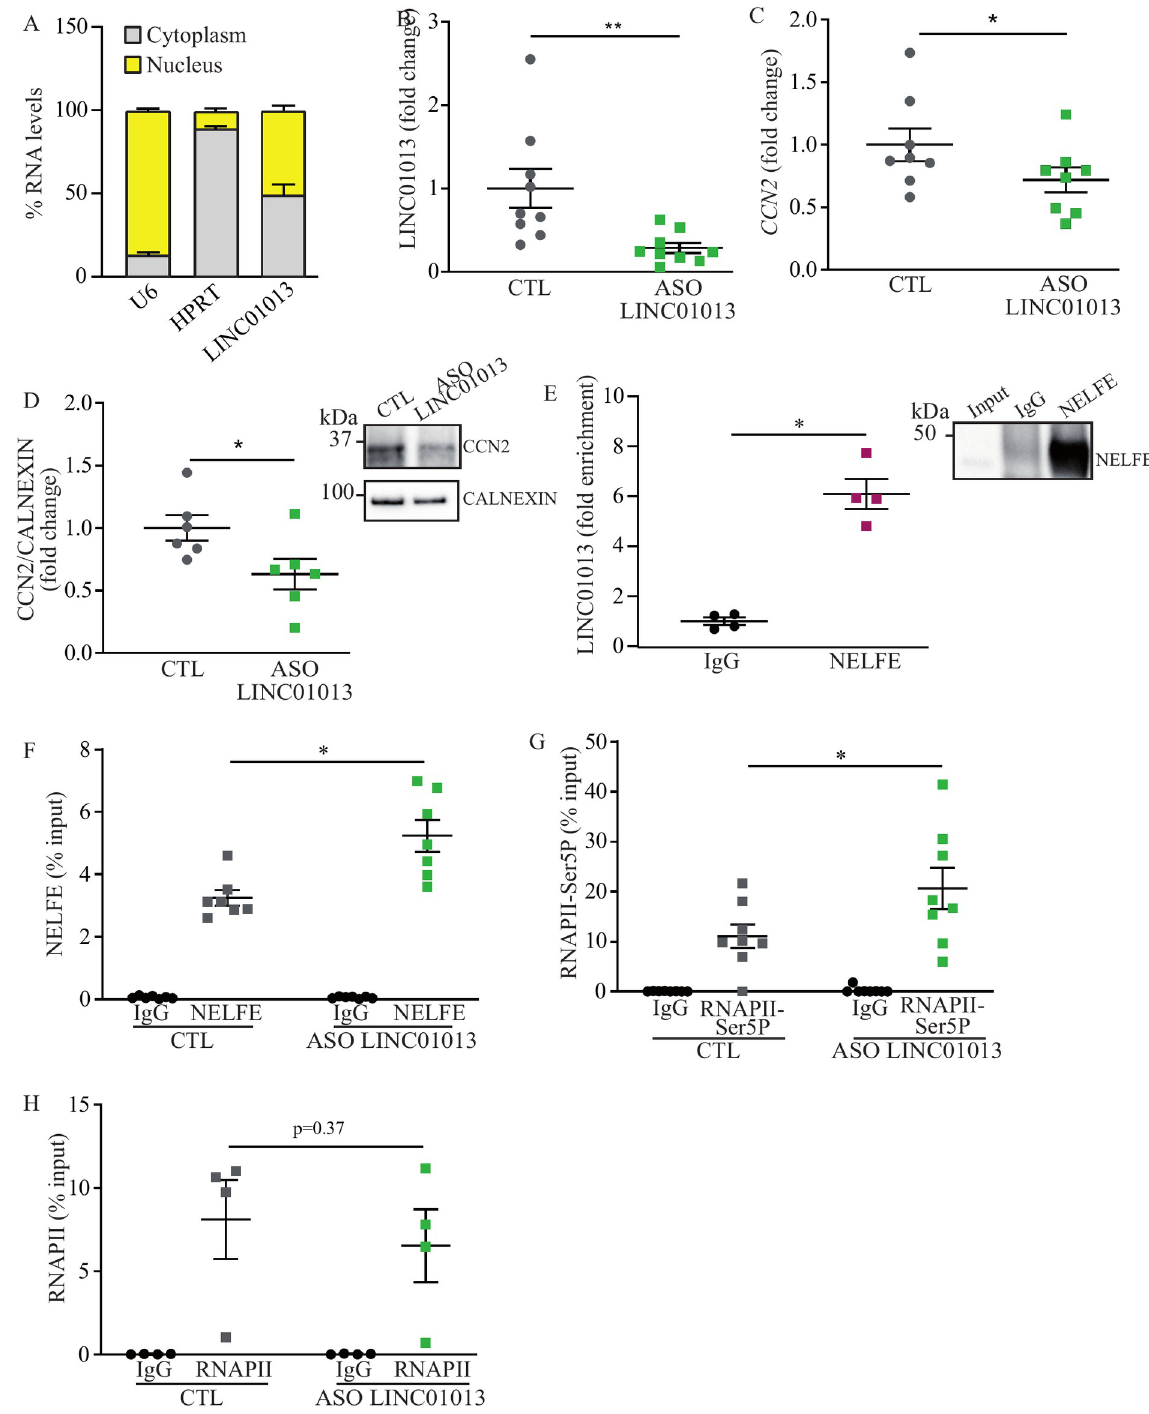
Fig 4. LINC01013 regulates the transcription at CCN2 . A) Cell fractionation and qPCR showing LINC01013 expression in both the nuclear and cytosolic compartments (n = 3). B-D) LINC01013 (n = 9) (B) and CCN2 (n = 8) (C) RNA levels and CCN2 protein (n = 6) (D) decrease following treatment with LINC01013 ASO. E) RNA immunoprecipitation assay (RIP) indicating an interaction between the LINC01013 and NELF-E protein, western blot demonstrating NELF-E immunoprecipitation (n = 4). F) ChIP-qPCR revealing a rise in NELF-E protein at the CCN2 promoter after treatment with LINC01013 ASO (n = 7). G-H) ChIP-qPCR showing increased RNAPII-Ser5P (n = 8) (G) occupancy at the CCN2 promoter after treatment with the ASO against LINC01013 , but unchanged total RNAPII (n = 4) (H).